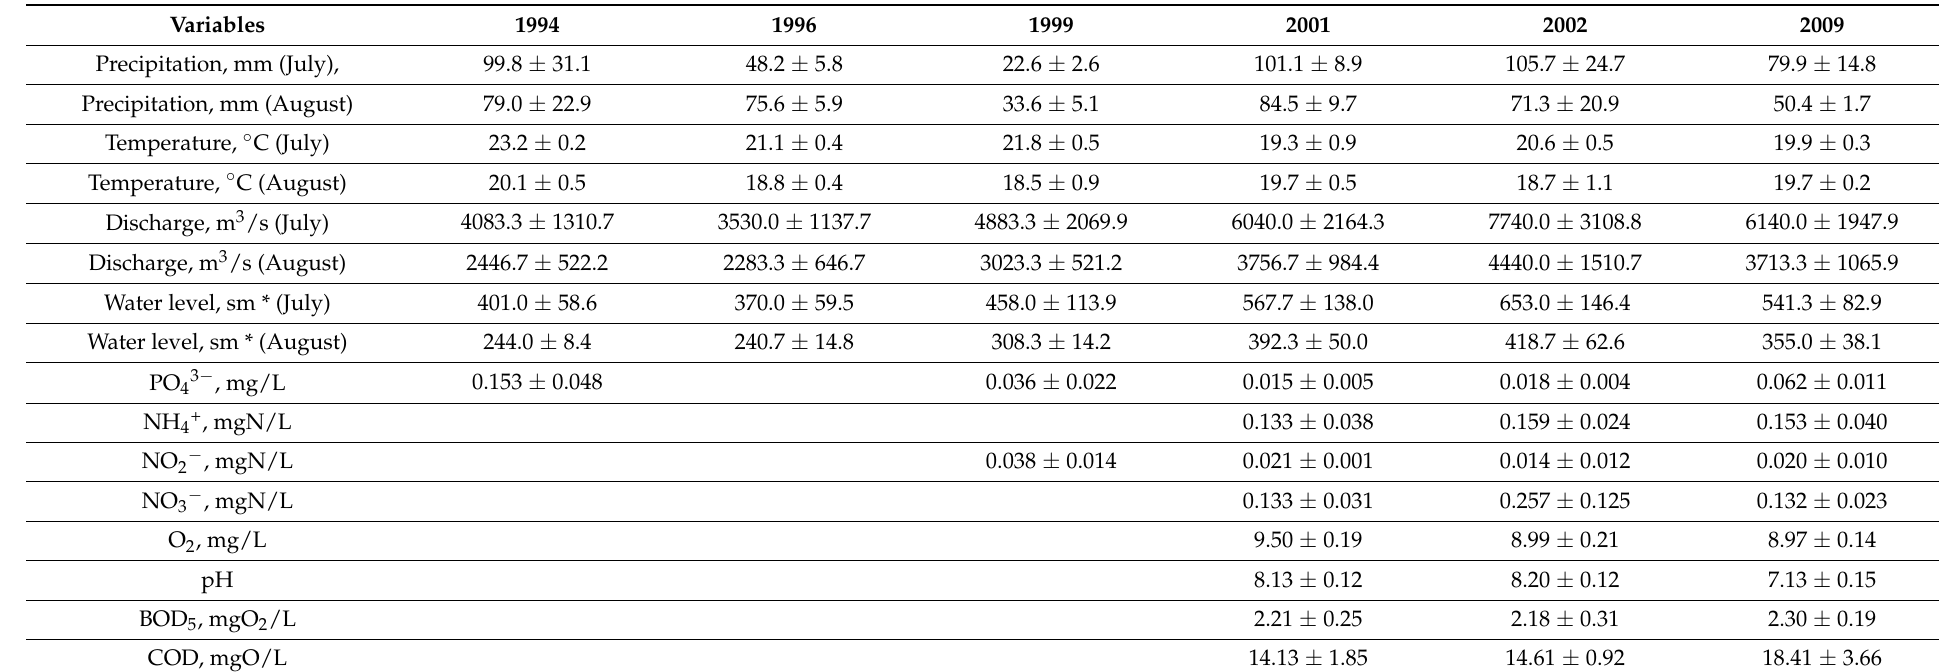
Table 2. Mean values and SE of hydrological and hydrochemical variables in Ob